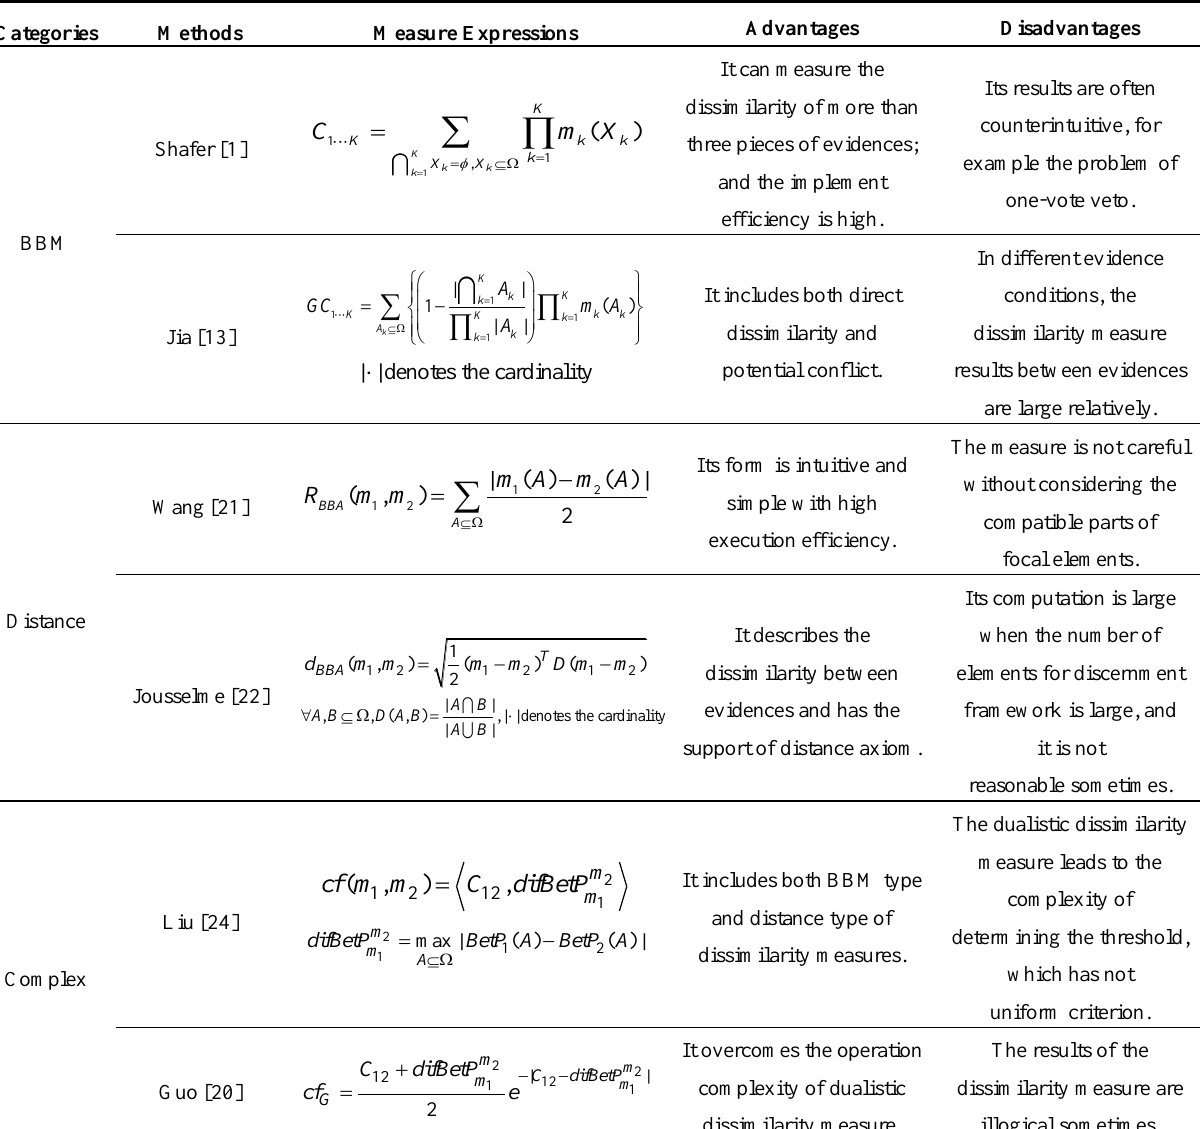
Table 1. Analysis of different dissimilarity measure